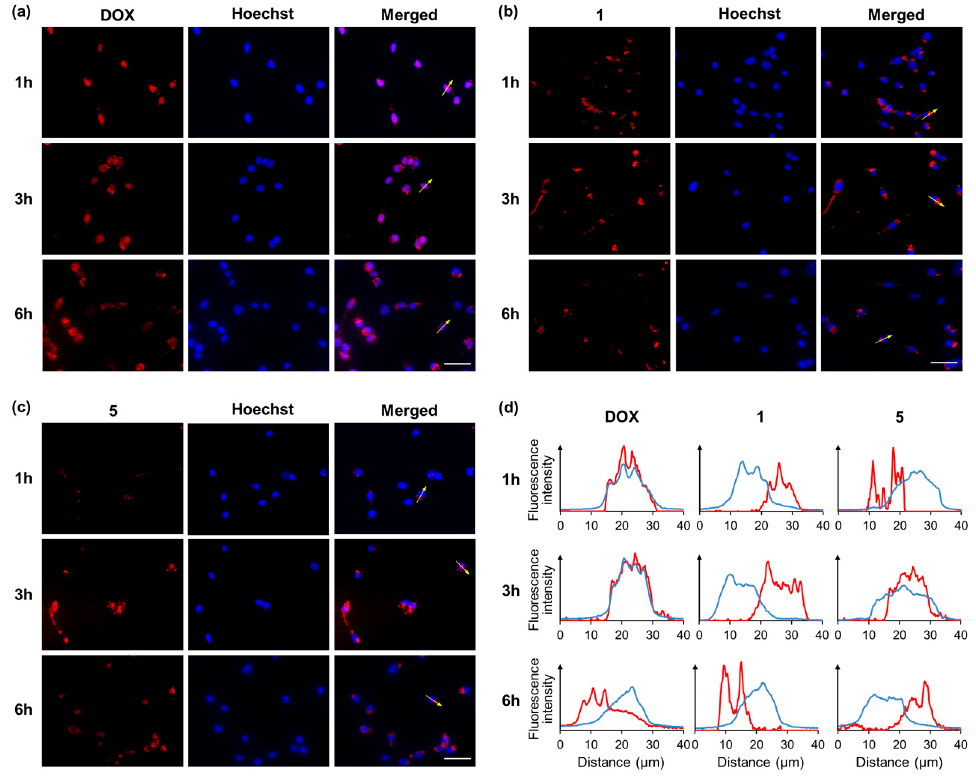
Figure 2. Intracellular localization of DOX derivatives. The fluorescent images were obtained at 1, 3, and 6 h after the addition of ( a ) DOX, ( b ) 1 , and ( c ) 5 . The fluorescence of DOX, 1 , and 5 is shown in red; the nucleus stained with Hoechst is shown in blue. ( d ) Line analysis of fluorescence signals of DOX-, 1 -, and 5 -treated cells (yellow arrow in merged images).